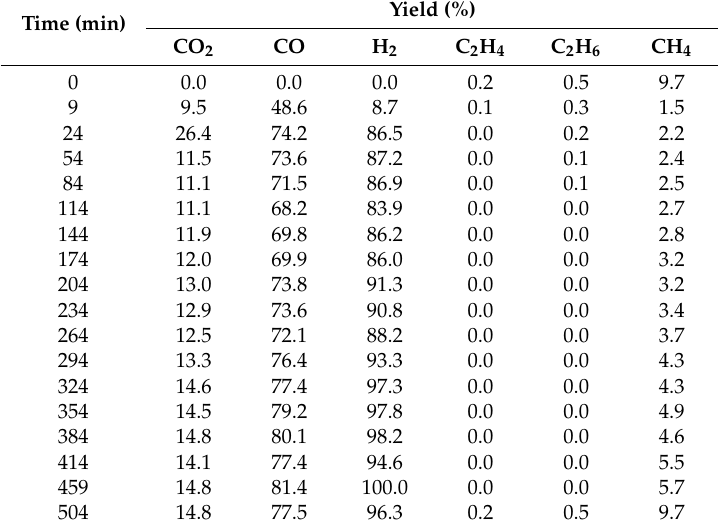
Table 9. Yield of each